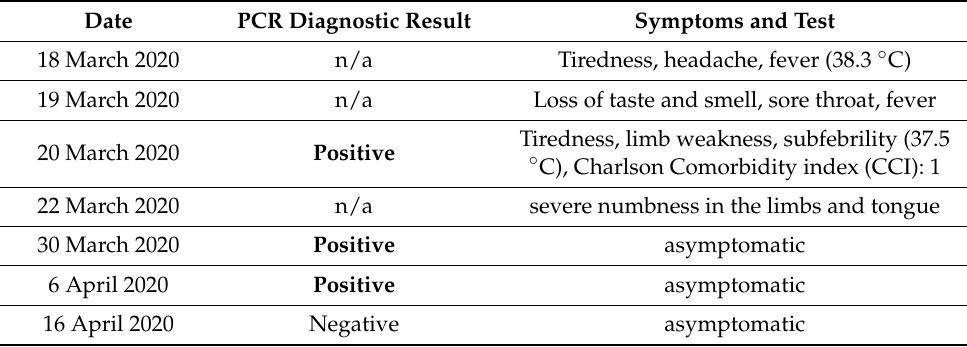
Table 1. Summary of the clinical history for the